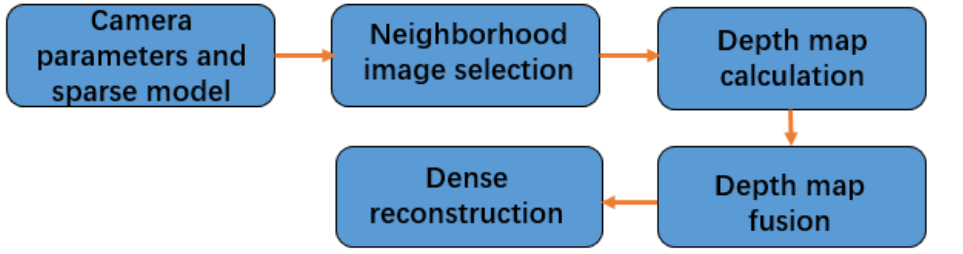
Figure 5. The MVS algorithm based on depth-map fusion.